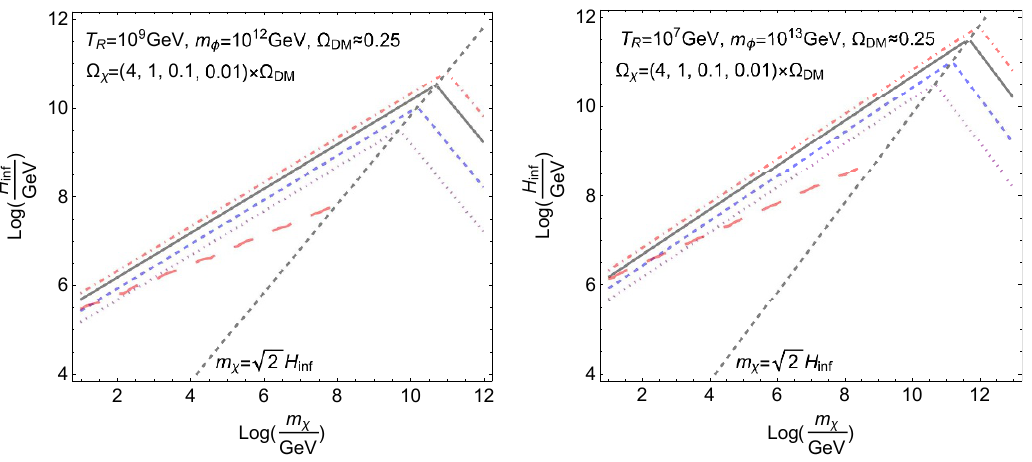
Figure 3 . Illustration with reheating temperature T R = 10 9 GeV (10 7 GeV) and in(cid:13)aton mass m (cid:30) = 10 12 GeV (10 13 GeV) for minimal coupling (cid:24) = 0 in the left (right) panel. Four di(cid:11)erent lines (dot-dashed, solid, dashed, and dotted) correspond to (cid:10) (cid:31) = (4 ; 1 ; 0 : 1 ; 0 : 01) (cid:2) (cid:10) DM . The long dashed red line shows the isocurvature perturbation limit and region above this line is